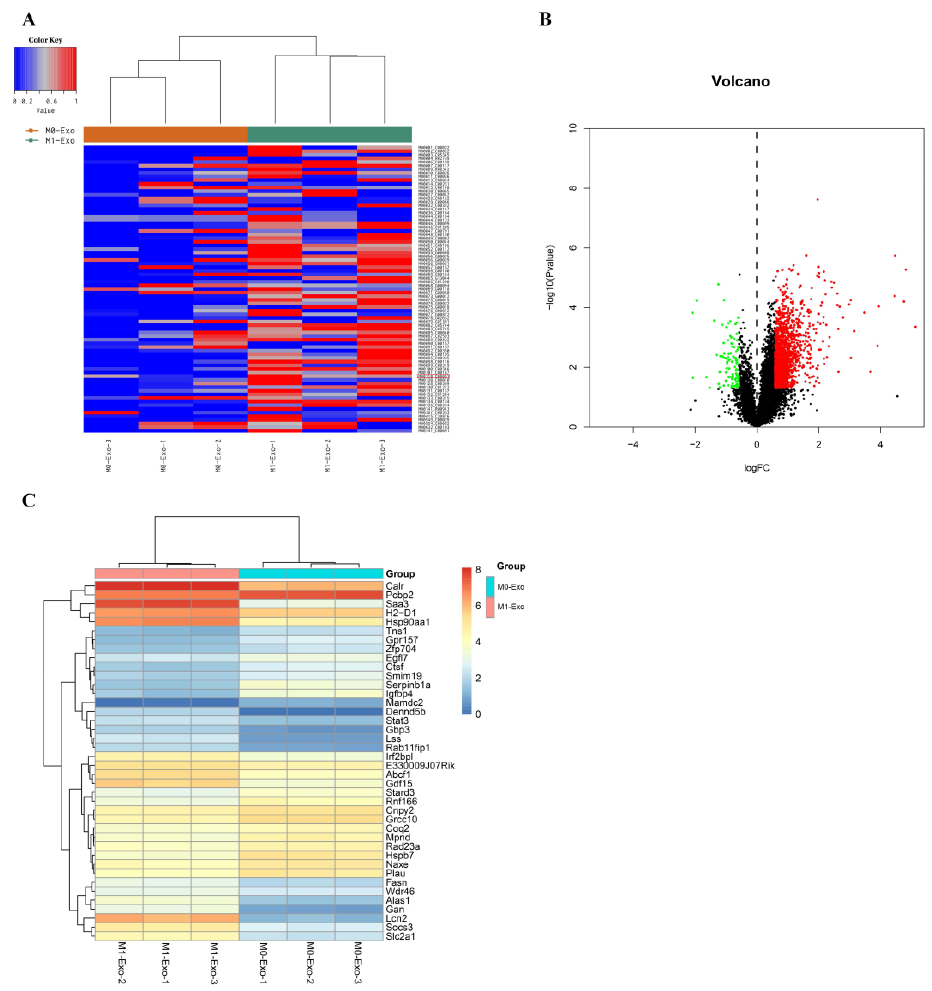
Figure 2. Differential analysis of metabolic activity and genes in M0-BV2 and M1-BV2 exosomes. ( A ) The heatmap of metabolic activity analysis between M0-BV2 and M1-BV2 exosomes. M00118_C00051 (red mark) is glutathione metabolism. ( B ) Volcano plot of upregulated ( n = 1557, red) and downregulated DEGs ( n = 102, green) in M0-BV2 and M1-BV2 exosomes. The black dots mean non-difference. ( C ) The heatmap shows the expression patterns of DEGs (top 40) in M0-BV2 and M1-BV2 exosomes.